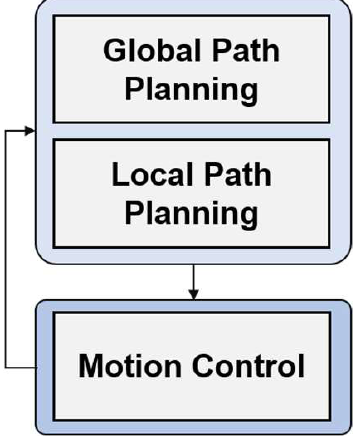
Figure 1. Autonomous driving system architecture.